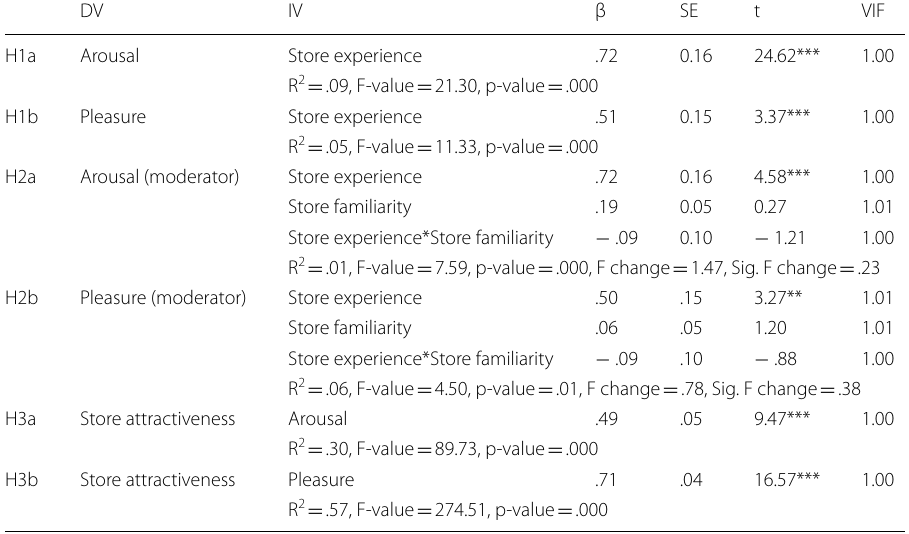
Table 4 Hypotheses testing